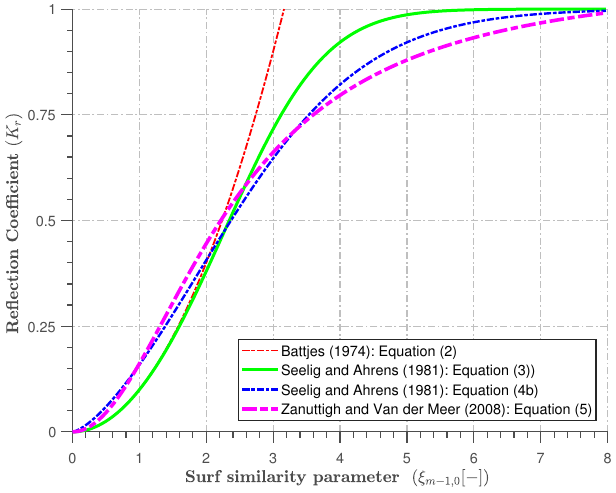
Figure 1. An illustration of the prediction of the reflection characteristics of smooth impermeable